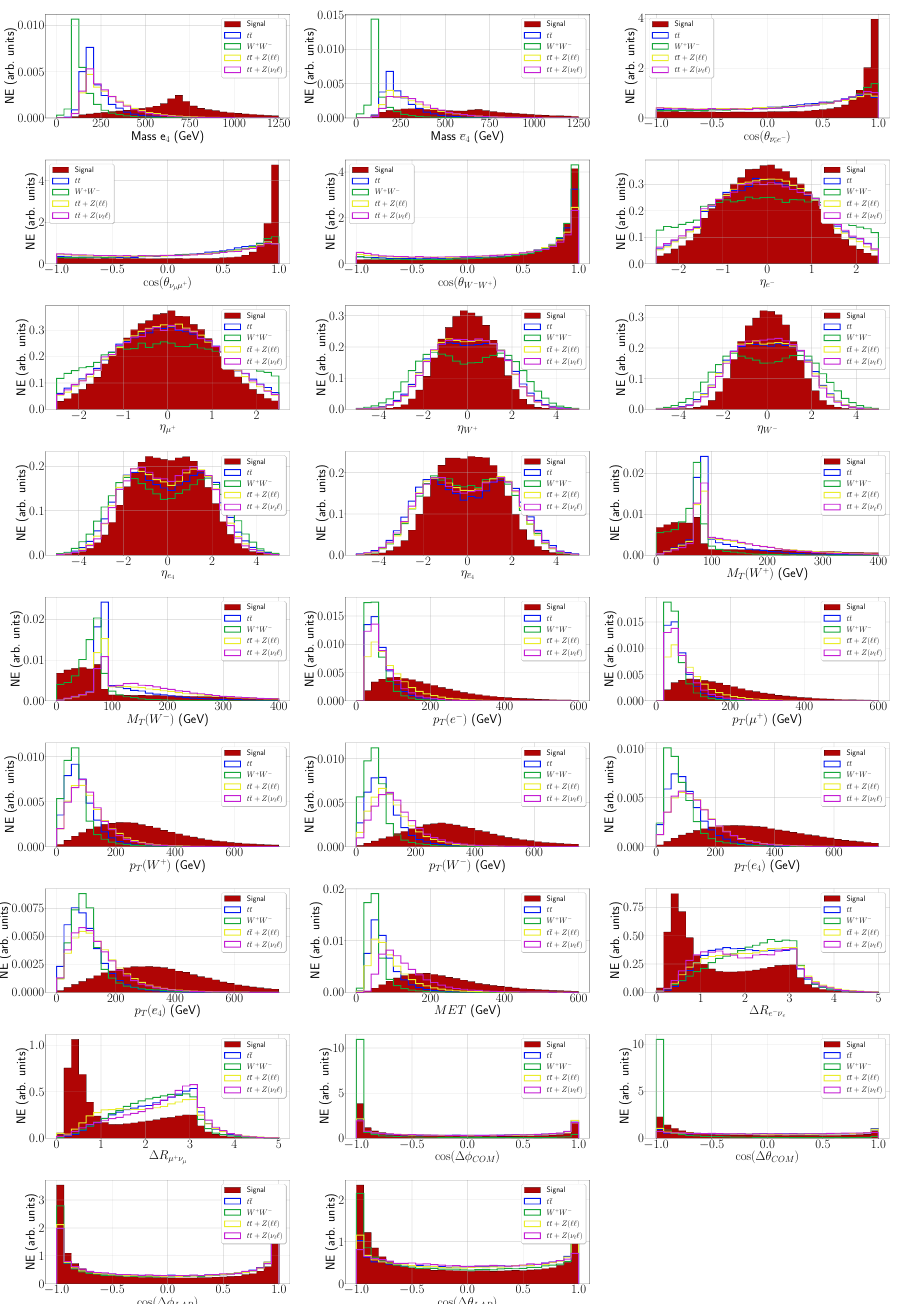
Figure 21. Dimensionless (angular) and dimension-full (kinematic) observables at lab reference frame for ZA channel (solid red), with t ¯ t (blue line), W + W − (green line), t ¯ t + Z ( ‘ + ‘ − ) (yellow line) and t ¯ t + Z ( ν ) (purple line) backgrounds where it is considered 30 bins for all histograms. ‘ ‘ (cid:1) , From top left to bottom right, we have distributions for e and ¯ e mass, cos( θ ) , cos (cid:0) θ 4 4 ν µ µ + ¯ ν e e − cos( θ ) , pseudo-rapidity for e − , µ + , W + , W − , e and ¯ e , transverse mass for W + and W − , 4 4 W + W − transverse momentum for e − , µ + , W + , W − , e and ¯ e , MET, ∆ R , ∆ R , cos(∆ φ ) and 4 4 µ + ν µ e − ¯ ν e cos(∆ θ ) in the lab and e ¯ e CM frames. Note that ν is the reconstructed missing energy vector, 4 / 4 according to the discussion in section